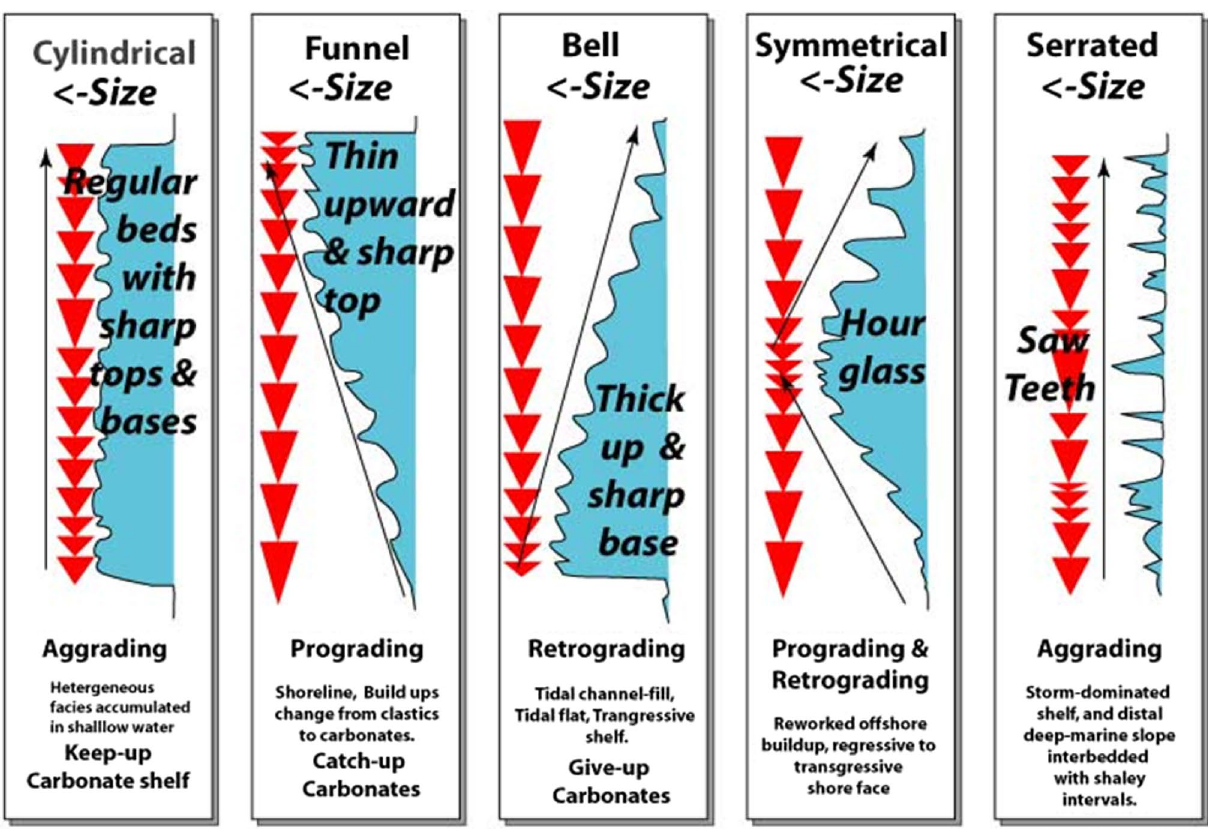
Fig. 18 Carbonates stacking patterns based on GR log trends (Kendall